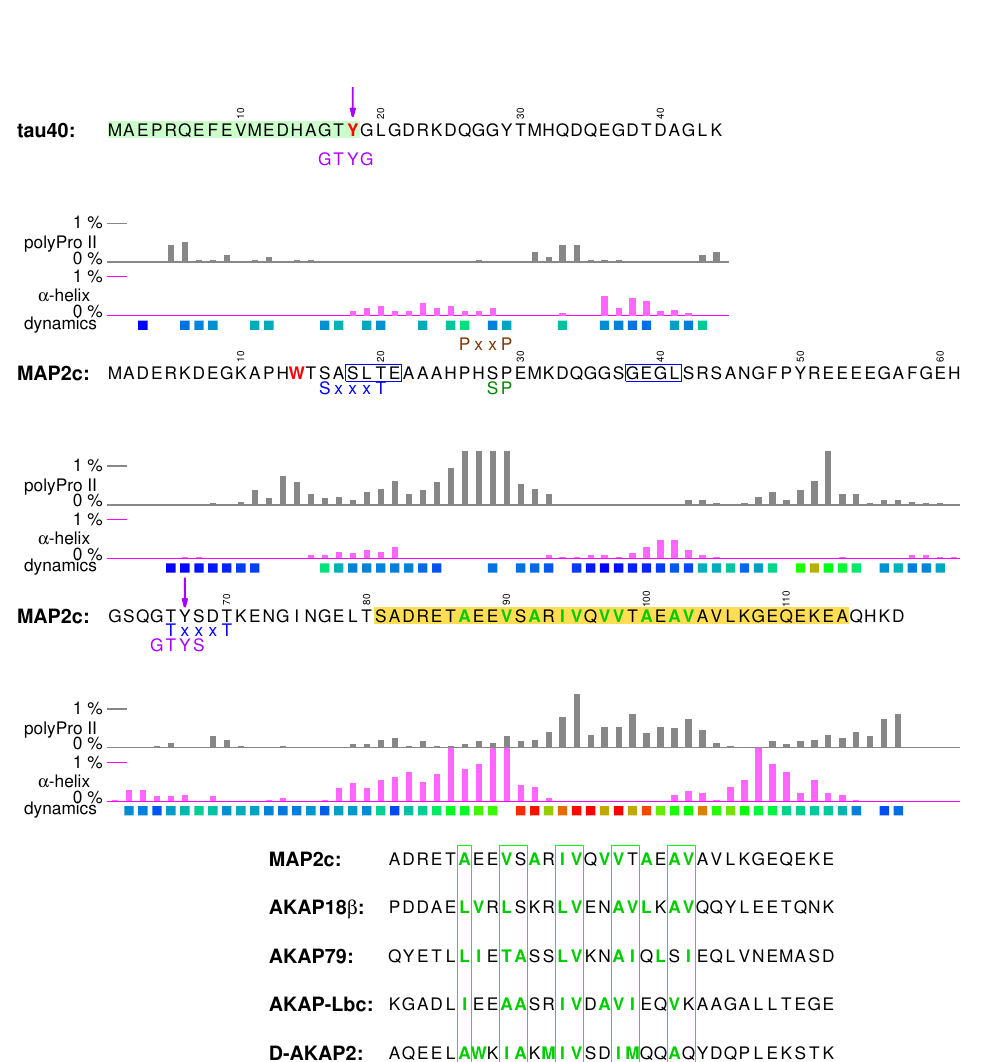
Figure 3. N-terminal sequences of human tau40 and rat MAP2c. The pale green and yellow boxes indicate the region of tau interacting with membranes and the region of MAP2c interacting with the regulatory RII subunit of PKA, respectively. Highly conserved residues are shown in red. Hydrophobic residues in the region interacting with the regulatory RII subunit of PKA are shown in green. Phosphorylated tyrosines are marked with purple arrows. Minimal SH3 interaction motifs (PxxP) are shown in brown above the sequences. Recognition motifs of proline-directed kinases (green) and GSK3 β (blue), and Fyn phosphorylation motifs (purple) are shown below the sequences. Populations of continuous stretches of seven amino acids in the α -helical and polyproline II conformations in the ensembles of structures selected by the ASTEROIDS analyses based on measured NMR chemical shifts [31,57] are shown as pink and gray bars placed in the middle of the stretches, respectively. Residues forming β -turns are shown in blue frames. Dynamics of individual amino acids, measured as transverse NMR relaxation rate, is described by colors of the boxes below the secondary structure symbols (blue corresponding to flexible residues with the relaxation rate of 2s − 1 or lower, red corresponding to the most ordered residues with the relaxation rate of 10 s − 1 or higher). The presented values are the relaxation rates measured at 700MHz and 5 ◦ C for tau40 [38] and values recalculated from relaxation rates measured at 950 MHz and 27 ◦ C for MAP2c [57] in order to account for the magnetic field difference. No temperature correction was applied because relaxation rates of IDPs cannot be easily recalculated for a different temperature. Alignment with the sequences of well-ordered AKAPs is shown under the region interacting with the regulatory RII subunit of PKA (preferred positions of hydrophobic residues in the amphiphilic binding α -helices are shown in green